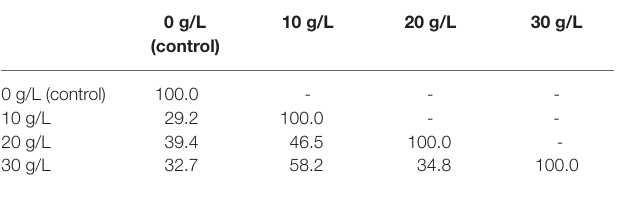
TABLE 4 | The similarity coefficient (%) between sludge samples at different NaCl